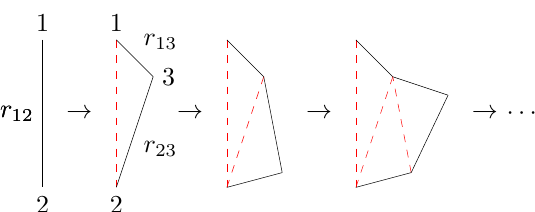
Figure 18. Schematic view of a dipole splitting. The initial dipole is spanned by partons 1 and 2, that emits a new parton (3), thus creating two new dipoles: the dipole spanned by partons 1 and 3 and the dipole spanned by partons 2 and 3. This can be succeeded by additional splittings as indicated by the additional (cid:12)gures following the